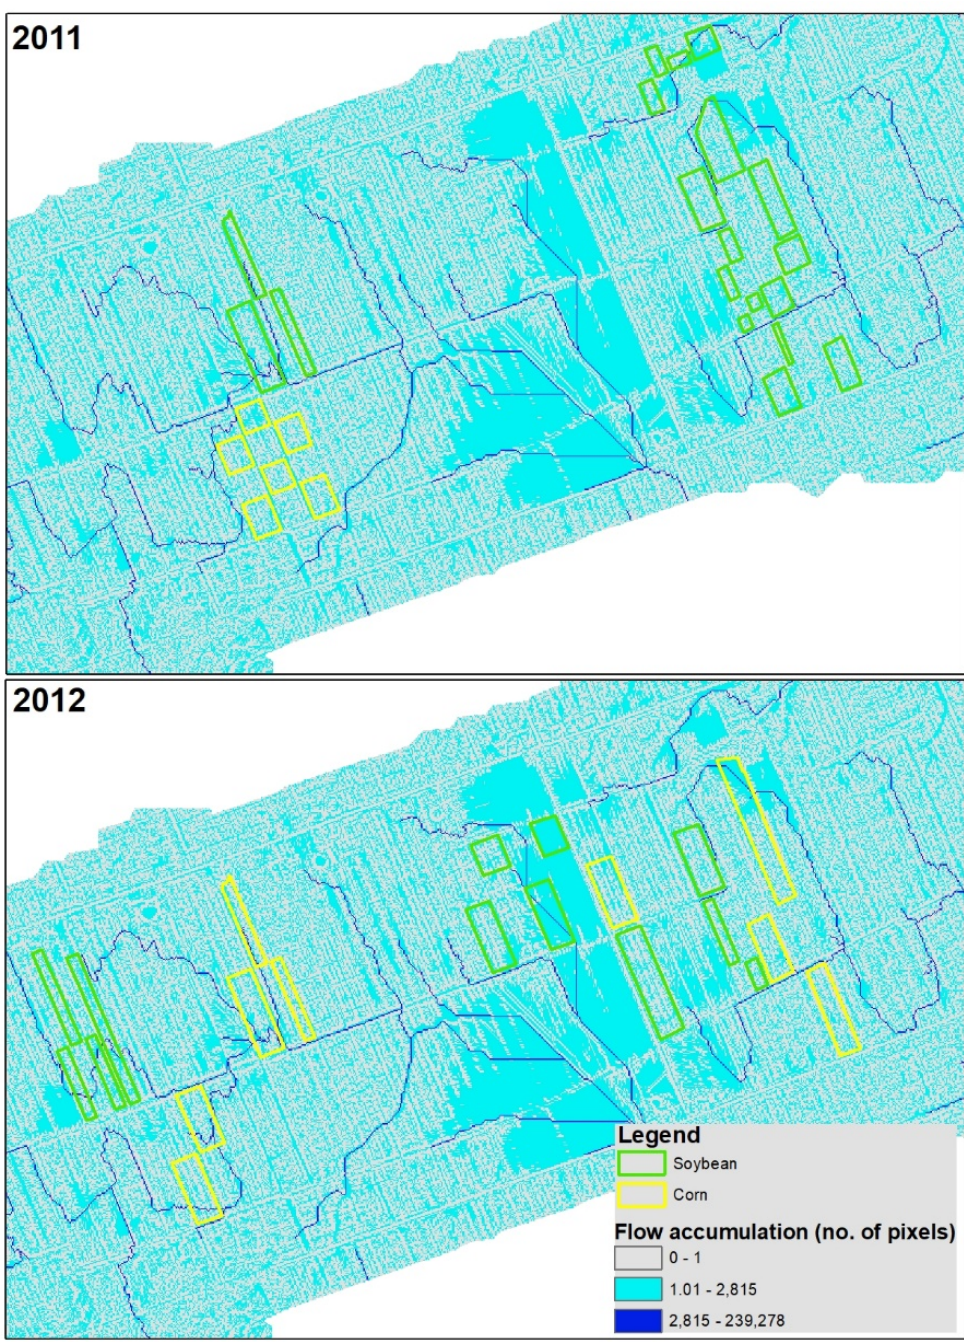
Figure 4. Flow accumulation where experimental fields were located during 2011 and 2012.